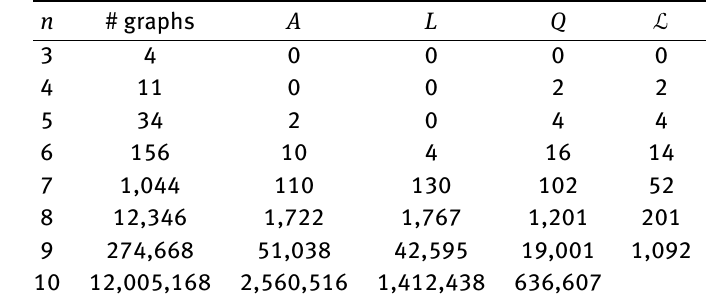
Table 3: Number of graphs with a cospectral mate with respect to each matrix. Counts for A , L , Q from [16], counts for L from [8].